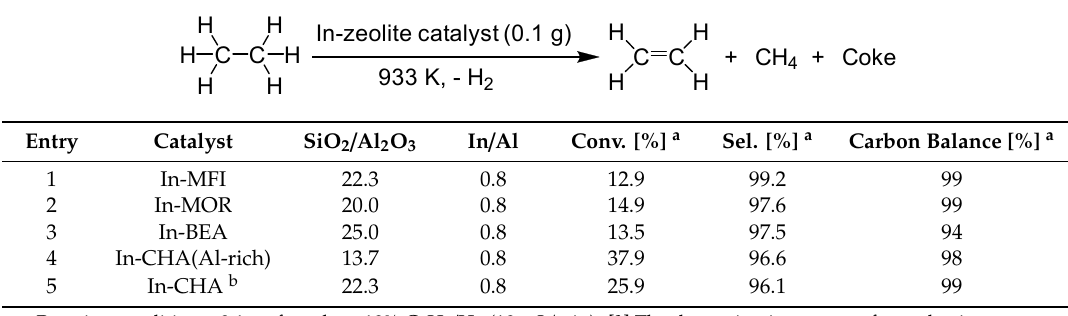
Table 1. Conversion, selectivity, and carbon balance values for 30 min of ethane dehydrogenation at 933 K using several In-exchanged zeolites.